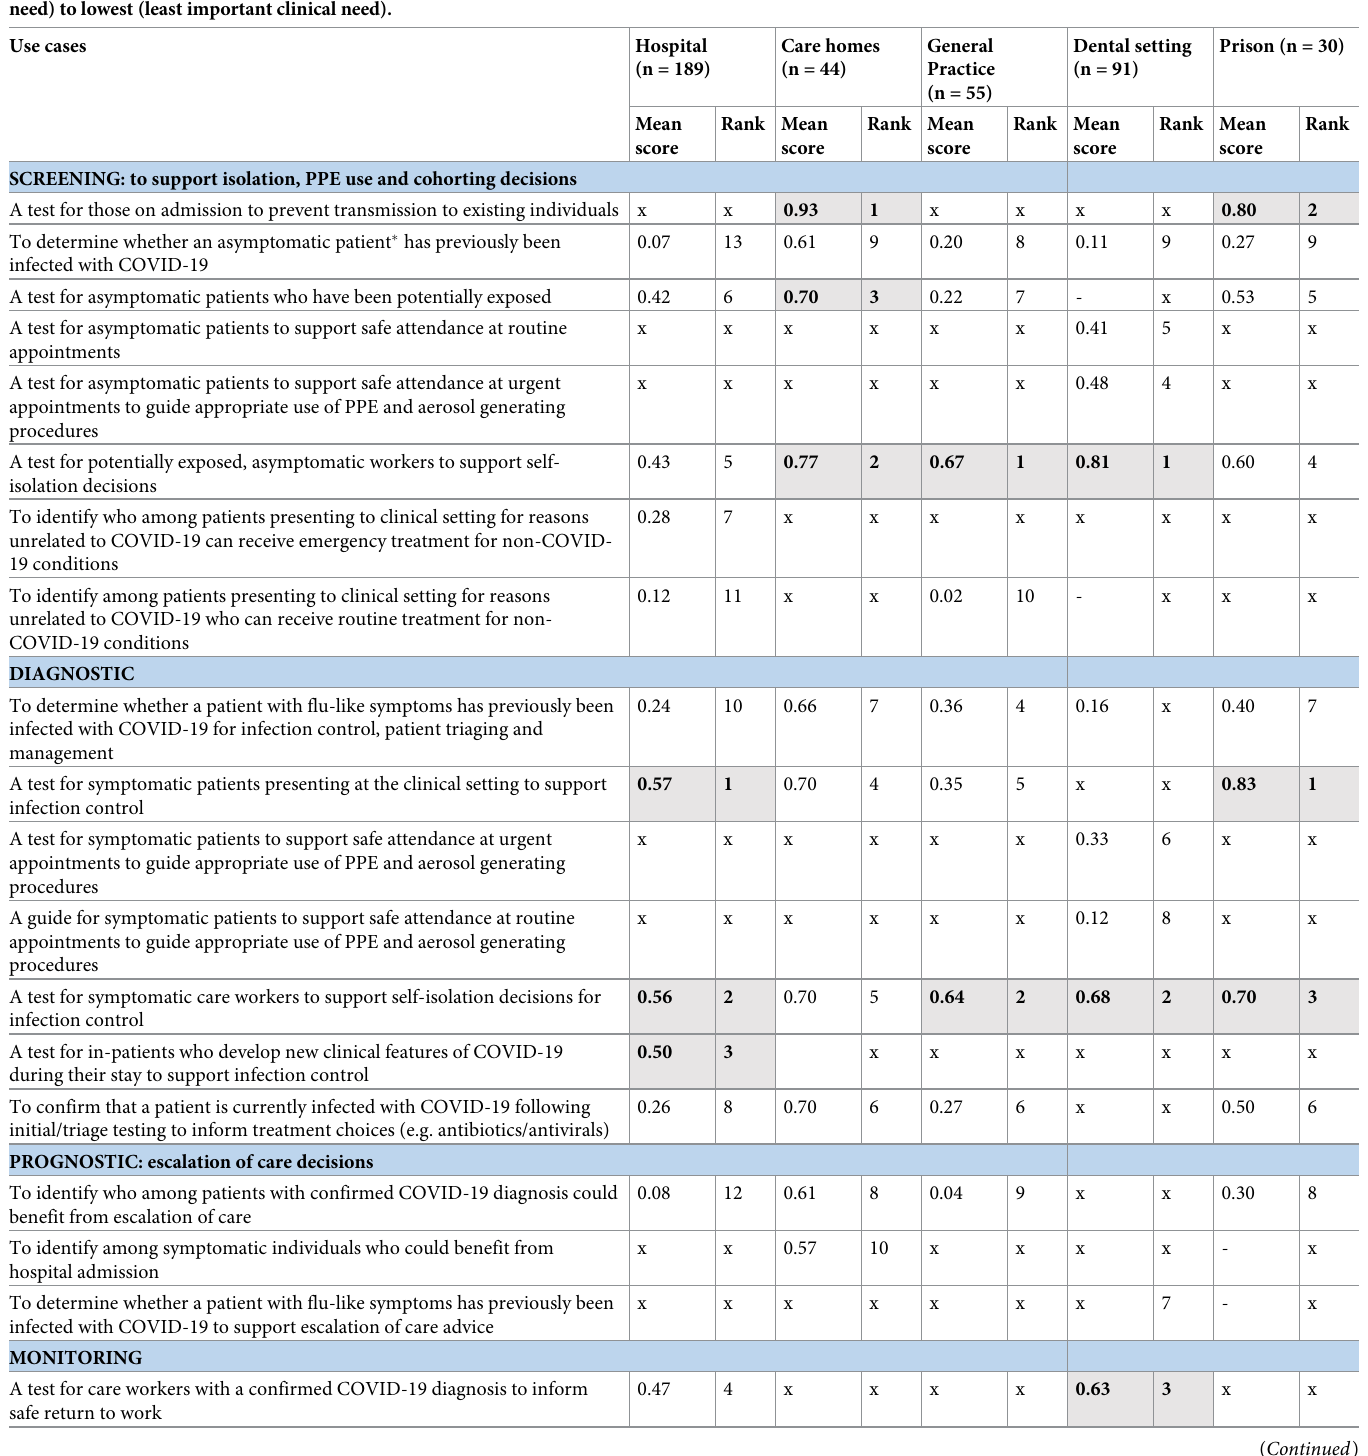
Table 2. Unmet clinical need priorities in each setting from respondents who worked in those settings, ranked by mean score from highest (most important clinical need) to lowest (least important clinical